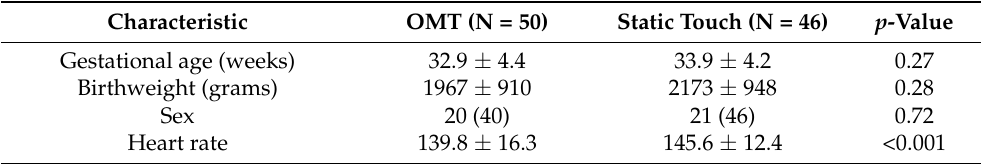
Table 2. General characteristics of the study sample at Baseline. Characteristic OMT (N = 50) Static Touch (N = 46) p -Value Gestational age (weeks) 32.9 ± 4.4 Birthweight (grams) 1967 ± 910 Sex Heart rate 139.8 ± 16.3 145.6 ± 12.4